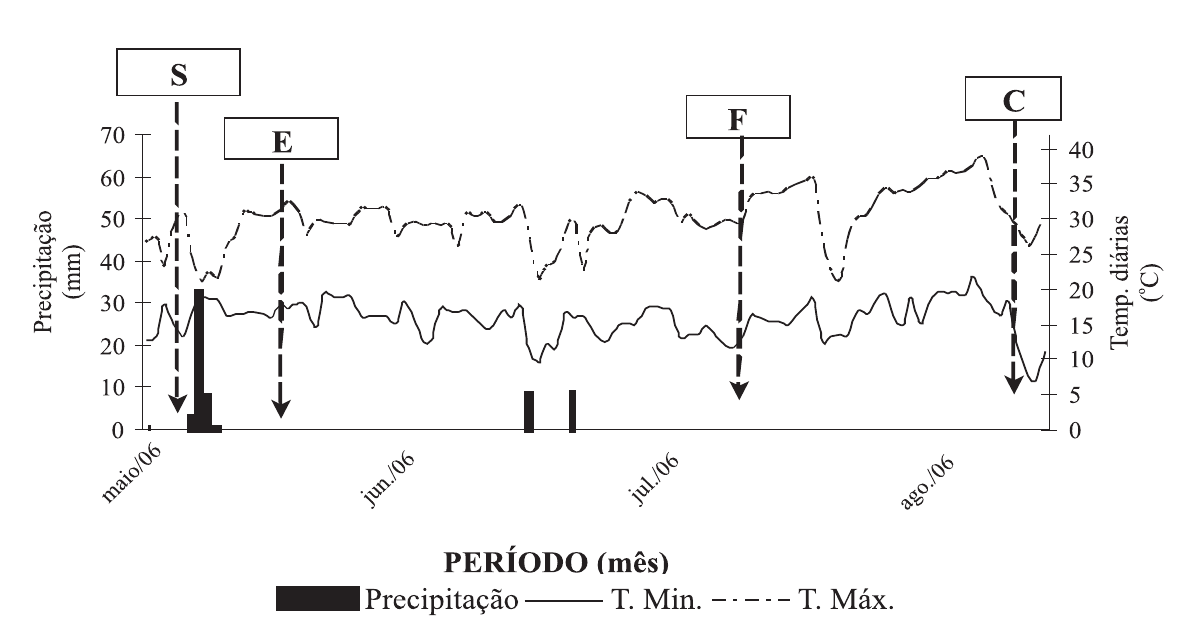
Figura 1 . Temperaturas máximas, mínimas e precipitação pluvial média durante a condução do experimento. Selvíria - MS, 2006. S – semeadura; E – emergência; F – florescimento; C – colheita.